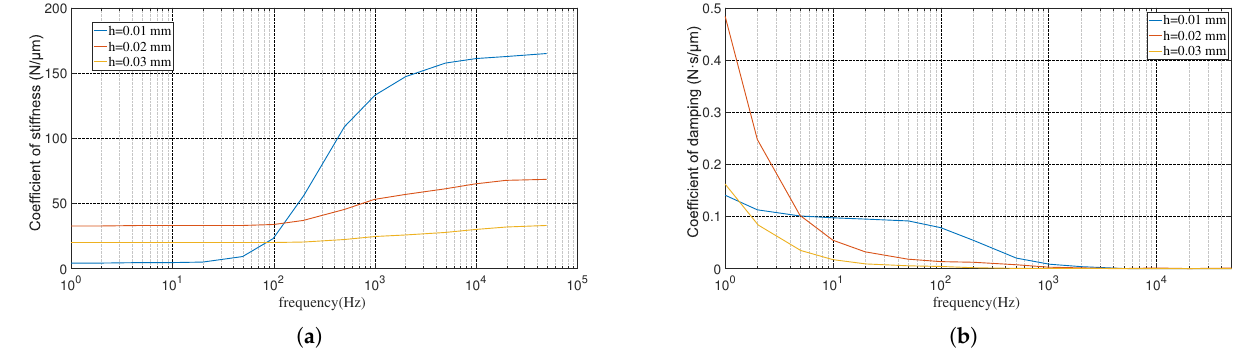
Figure 4. The dynamic characteristics of the gas film under different film thicknesses [41] (orifice diameter = 0.3 mm, gas supply pressure = 4 Mpa). ( a ) Change of dynamic stiffness with film thickness. ( b ) Change of damping with film